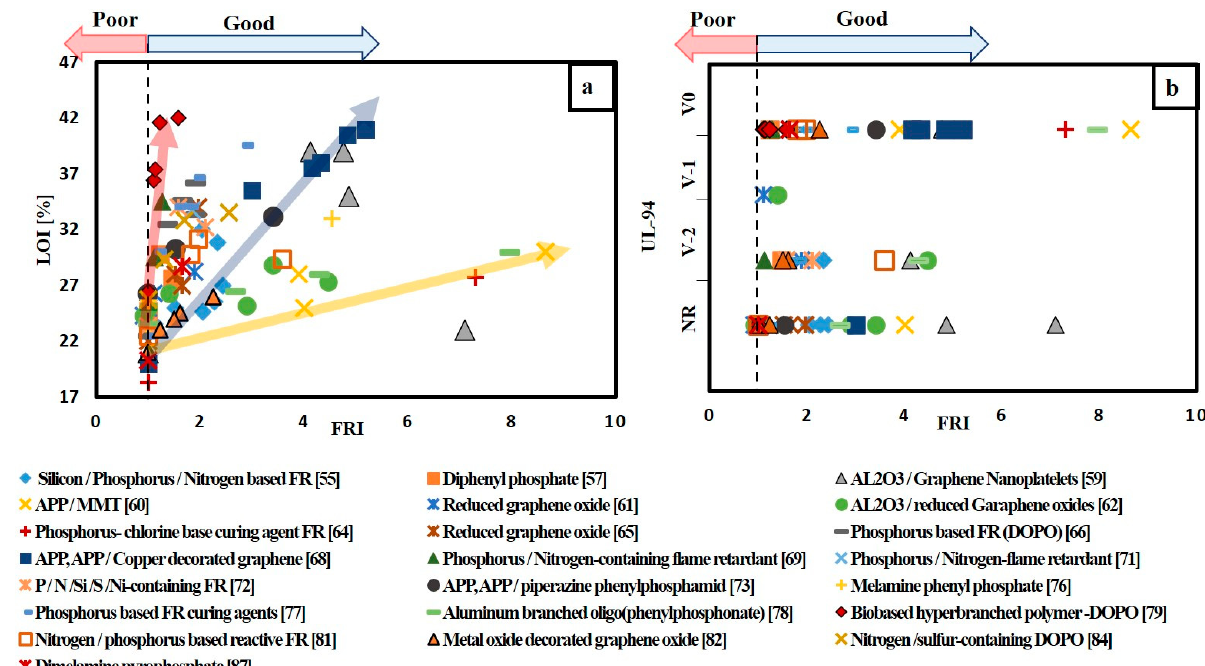
Figure 8. ( a ) FRI versus LOI for different FR/epoxy resin systems; ( b ) FRI versus UL-94 for different FR/epoxy resin systems.